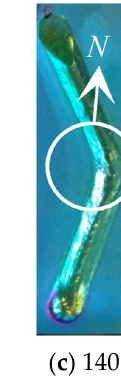
Figure 6. Overaccumulation of metal at the inflection point of small-angle straight-line forming. ( a ) The corner of the polyline is 45°; ( b ) The corner of the polyline is 85°; ( c ) The corner of the polyline is 140°.